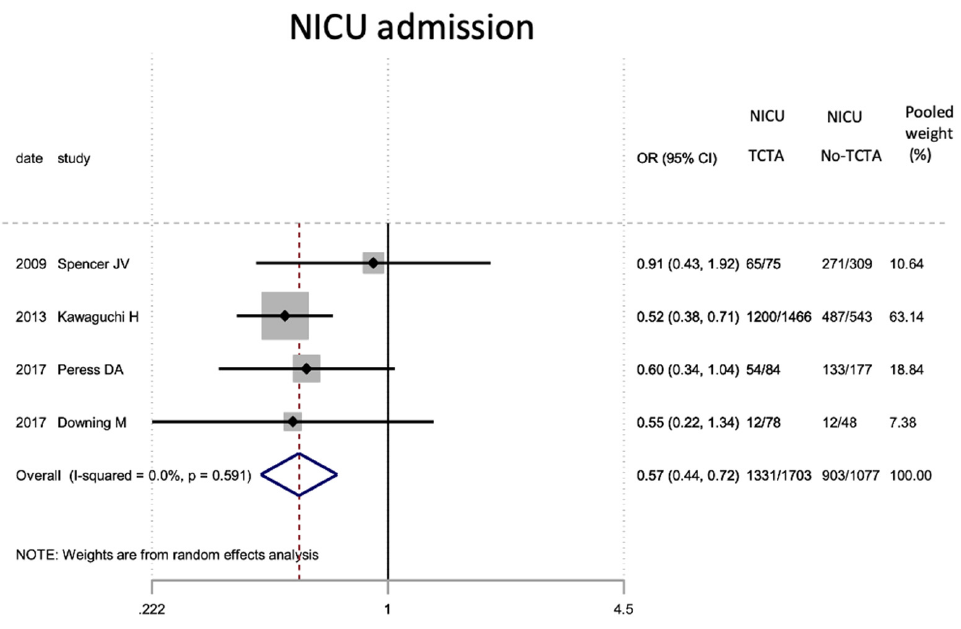
Figure 6. Results of the meta-analysis on the effect of chorionicity (TCTA vs no TCTA) on very low birth weight newborns (below 1500 g). Very LBW: very low birth weight; TCTA: trichorial-triamniotic, non-TCTA: non-trichorial-triamniotic. OR = odds ratio, CI = confidence interval.